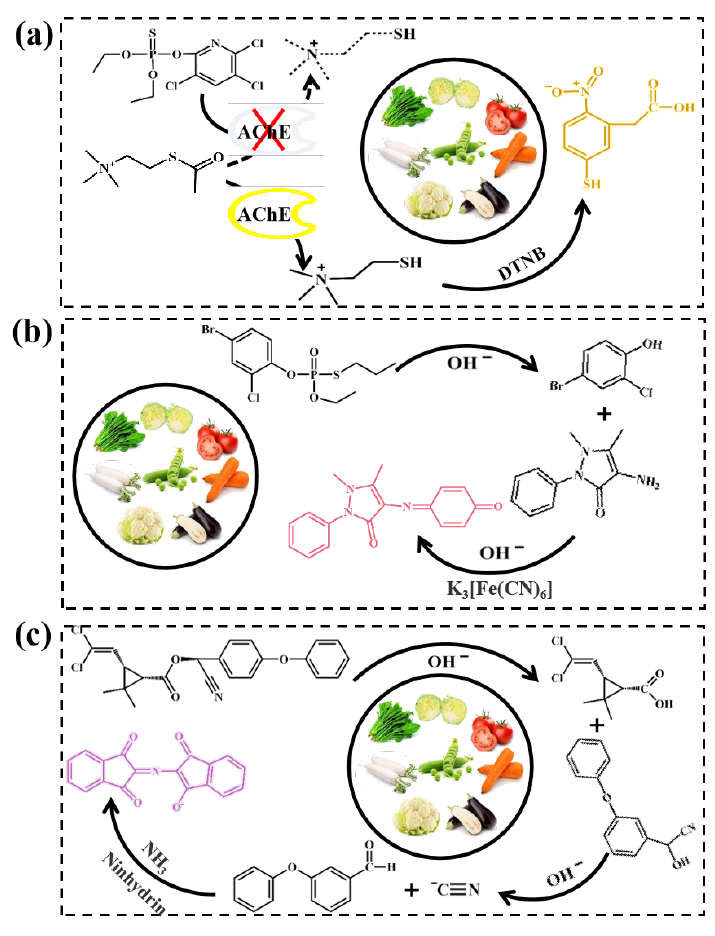
Figure 5. The reaction principle of ( a ) chlorpyrifos, ( b ) profenofos and ( c )